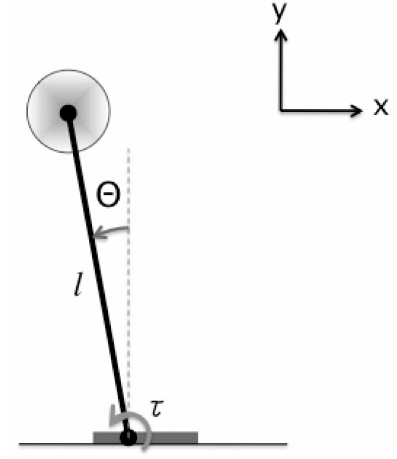
Figure 20. Modeling of the Single Support